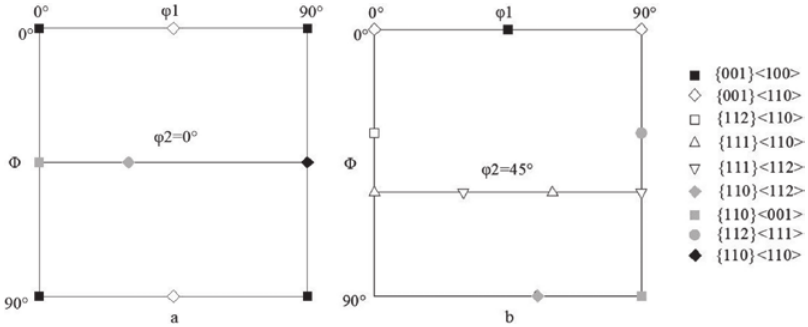
Fig. 7: Ideal preferred orientation in the Euler space: (a) φ 2 = 0°; (b) φ 2 = 45°